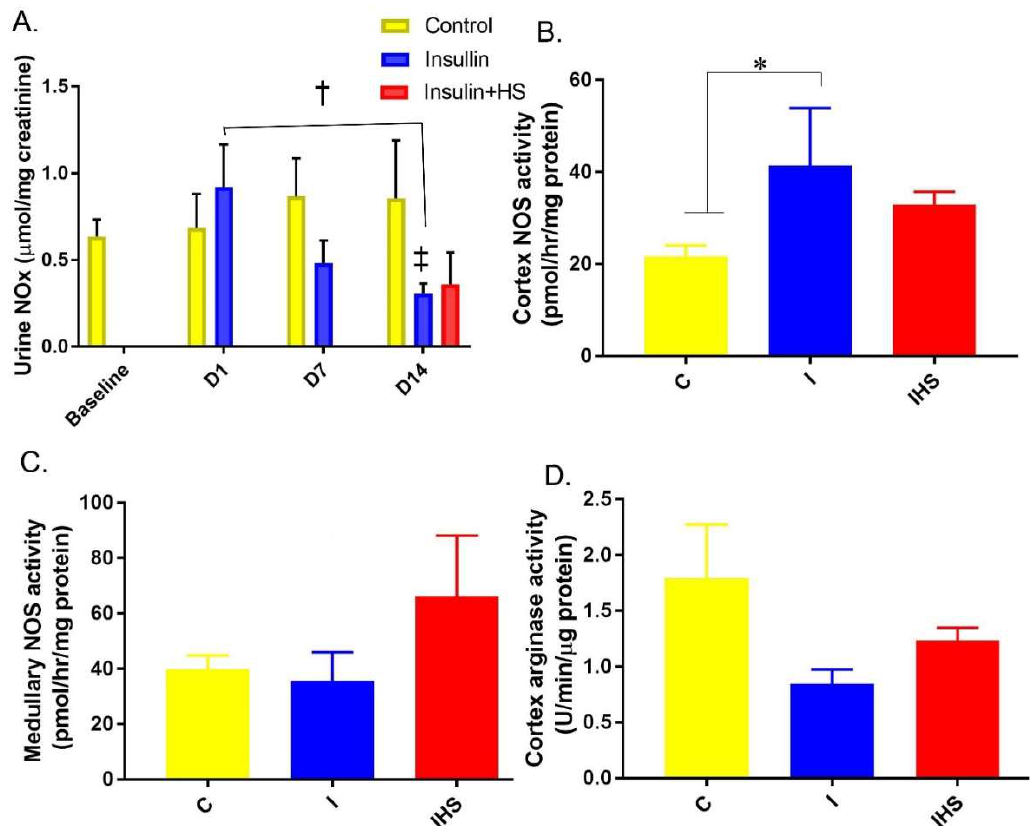
Figure 5. Urine NOx activity—( A ) Urine NOx (24-h collection) during baseline and days 1, 7, and 14; ( B ) cortex NOS activity; ( C ) Medulla NOS activity (combined inner medulla and inner stripe of the outer medulla); ( D ) cortex arginase activity; (mean ± sem, n = 8–12/group for ( A – C ) and 3–4/group for ( D )). * indicates a significant difference between groups ( p < 0.05); ‡ indicates a significant difference from baseline, and † between identified days, by two-way repeated measures (RM) ANOVA followed by multiple comparison’s testing.